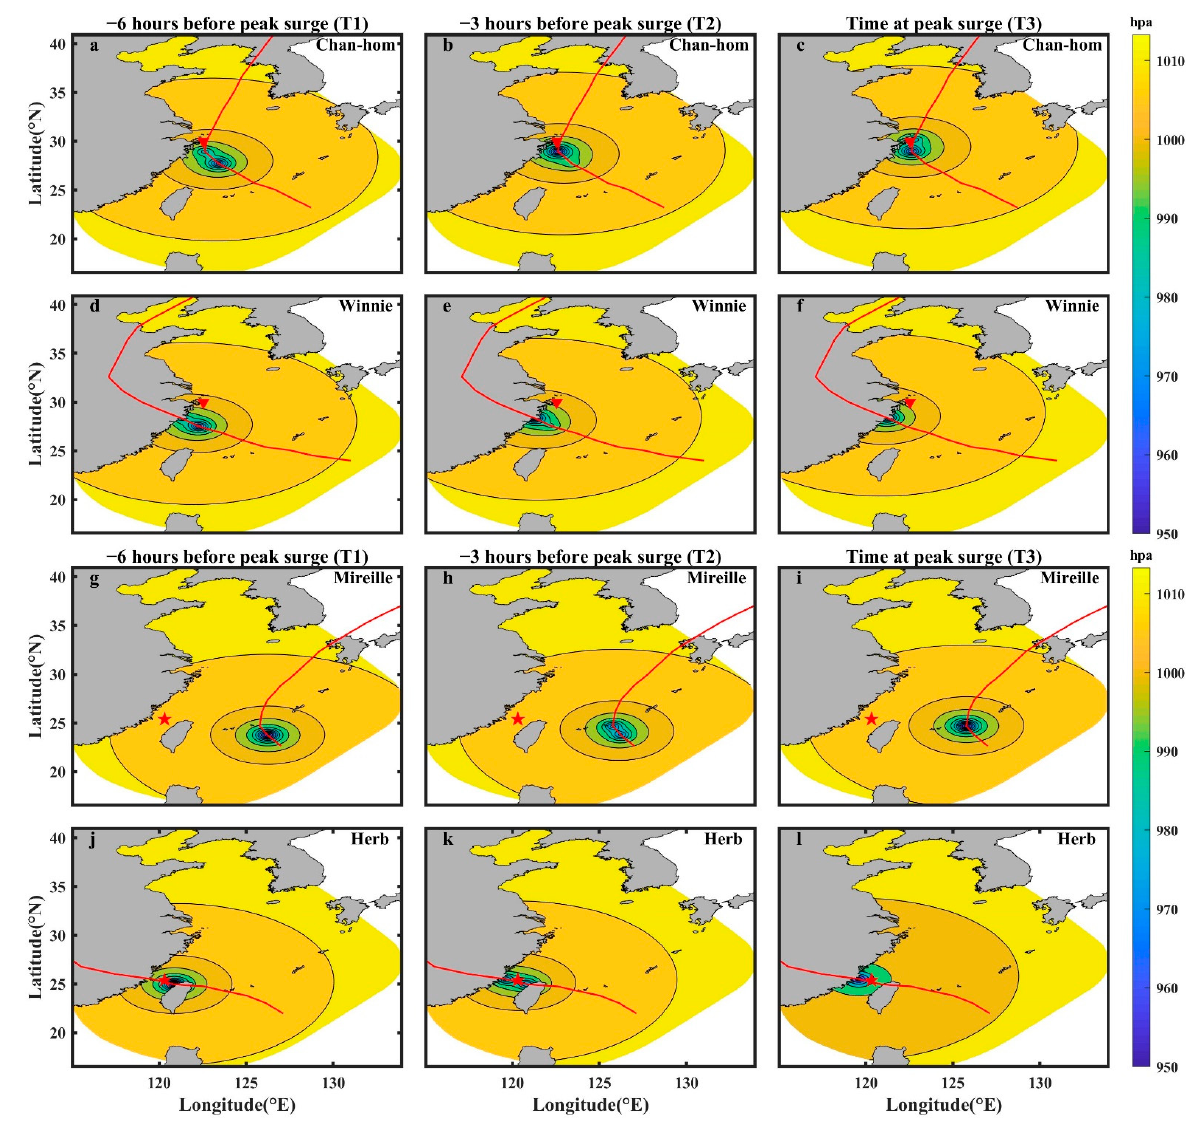
Figure 13. Model simulated pressure distribution at time T1, T2, and T3 (at LH station) for typhoon paths of Chan-hom ( a – c ) and Winnie ( d – f ); model simulated pressure distribution at time T1, T2, and T3 (at PT station) for typhoon paths of Mireille ( g – i ) and Herb ( j – l ). The red line represents the typhoon path.